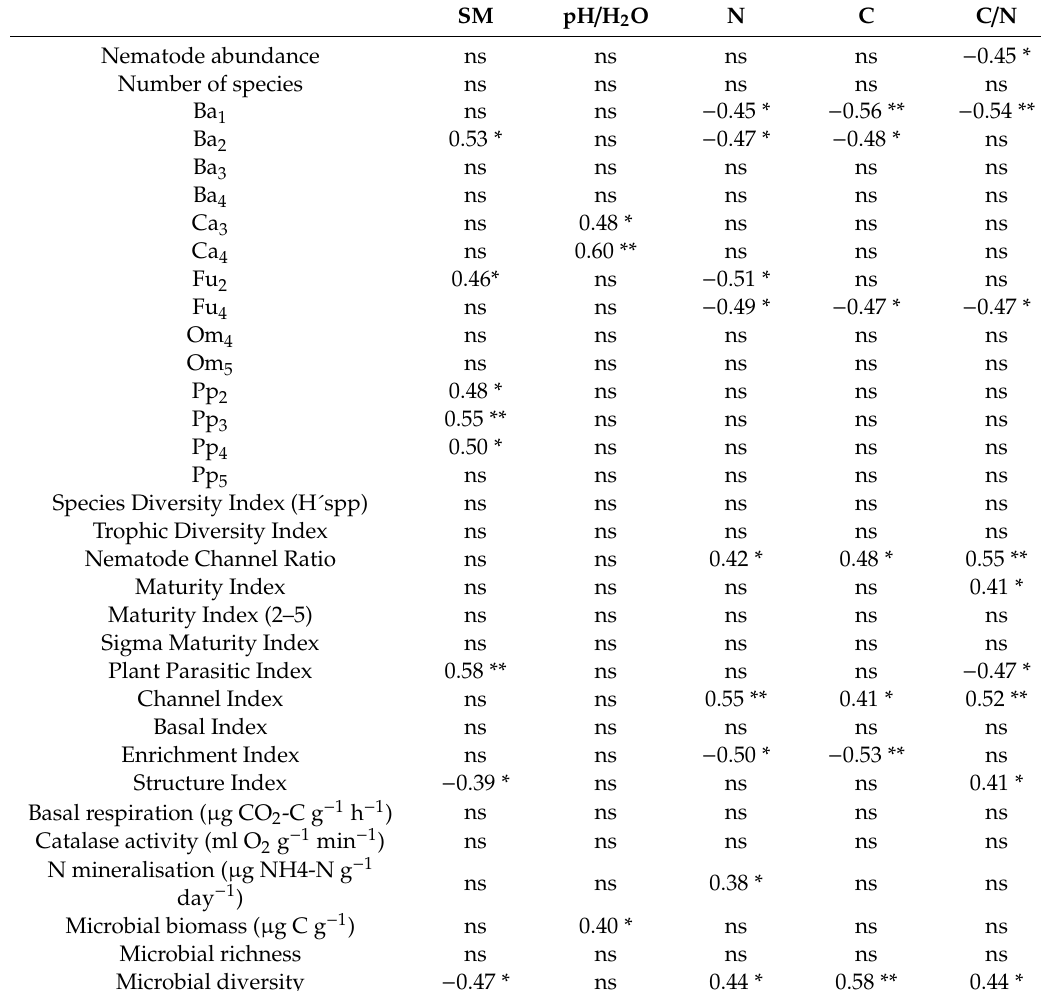
Table 5. Spearman´s rank correlation coe ffi cients between nematode abundance, species number, functionalguilds, nematodecommunity, andecologicalindices; microbialparametersandsoilproperties (SM, soil moisture content; pH / H 2 O; acidity; N, total nitrogen content; C, organic carbon content; C / N, carbon to nitrogen ratio).